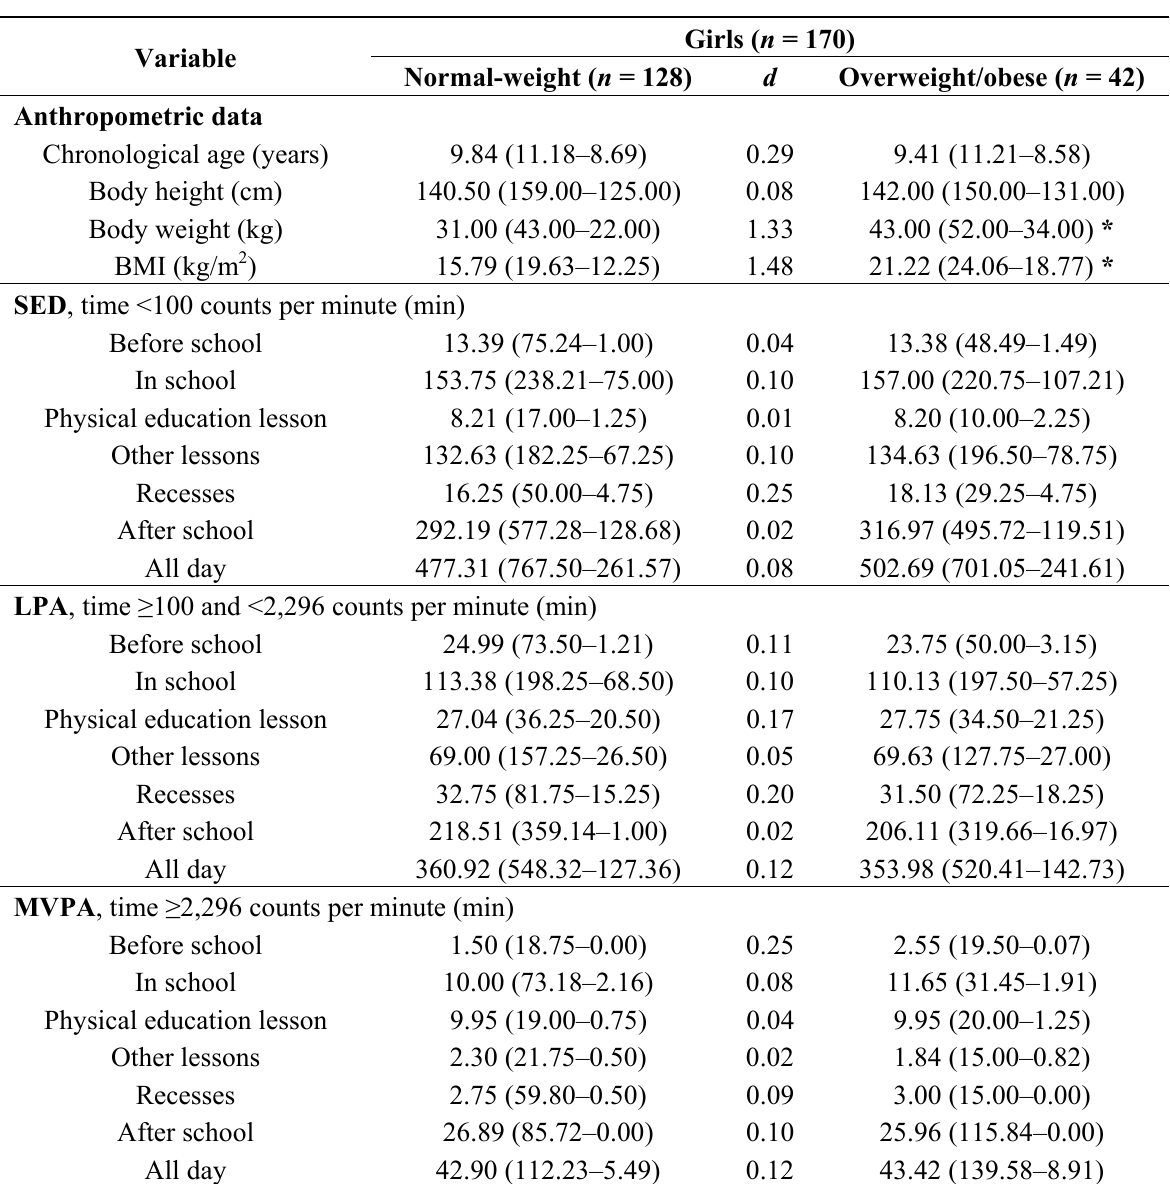
Table 1. Anthropometric characteristics and duration of sedentary time and physical activity levels during 2-day monitoring (median (full ranges)) in overweight/obese and normal-weight